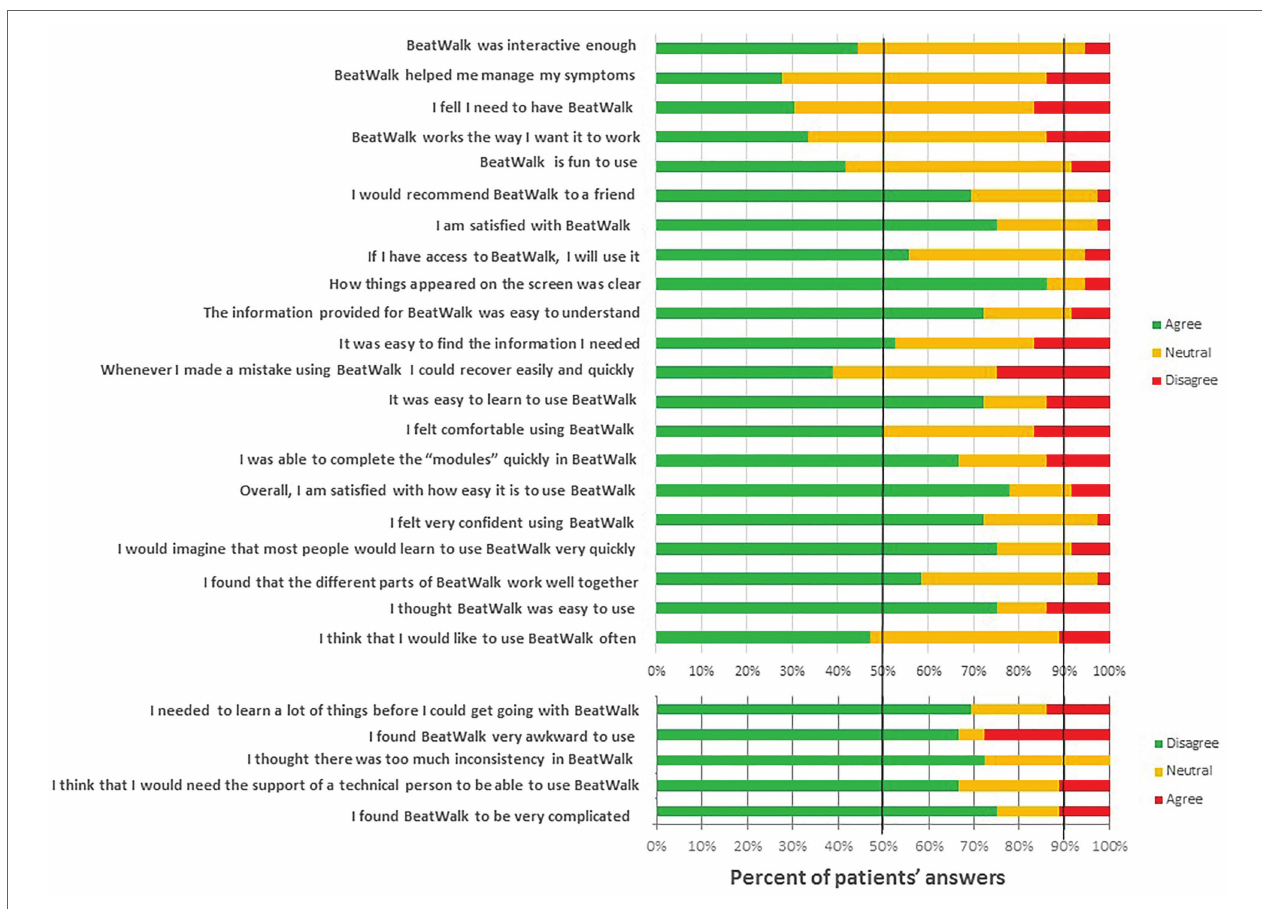
FIGURE 3 | Evaluation by the patients of different parameters of usability. In green responses favorable to BeatWalk, in orange, neutral, and in red